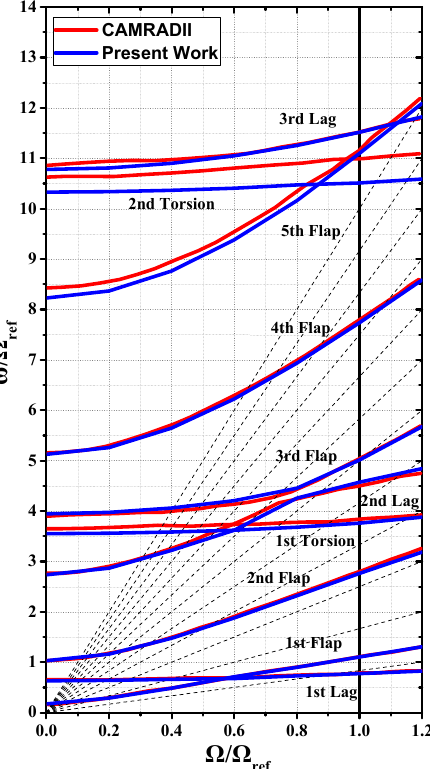
Figure 7. Frequency diagram of the Hart-II model rotor, predicted by the CSD model.